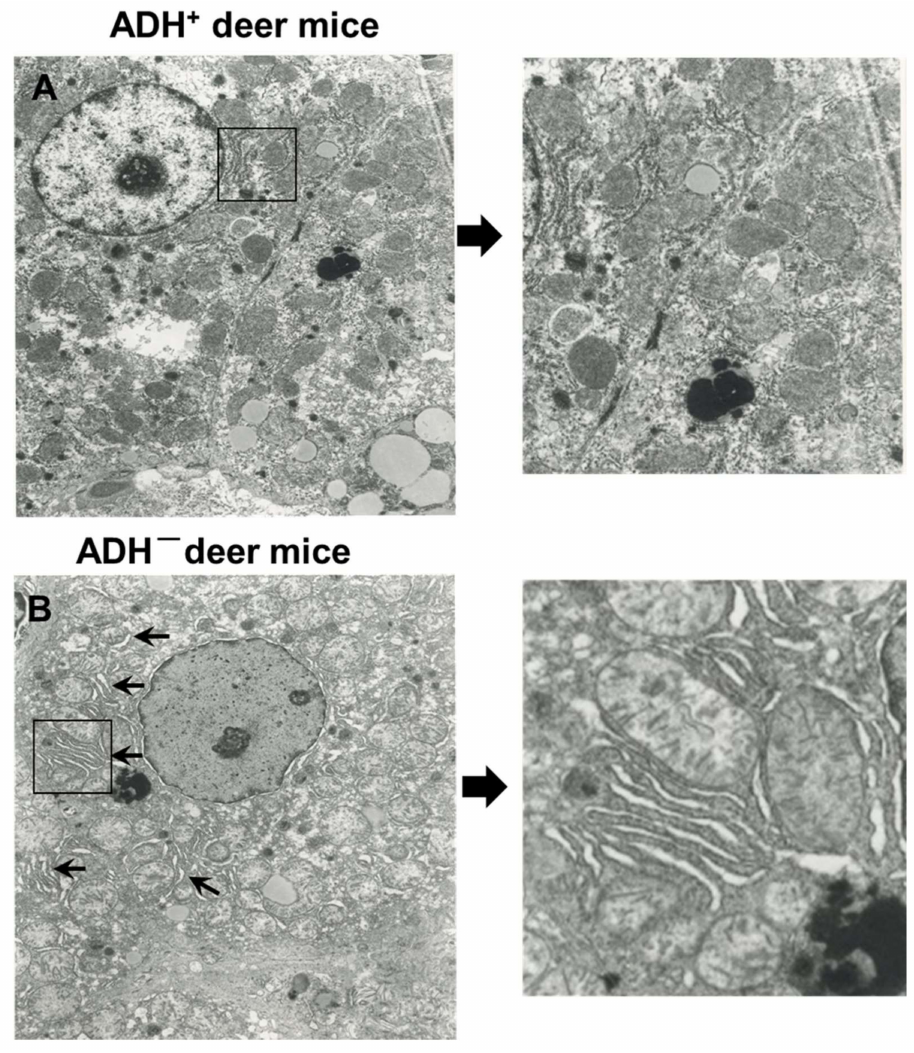
Figure 2. Electron micrographs of liver sections of ADH + deer mice ( A ) and ADH – deer mice ( B ) fed 3.5% EtOH for 2 months. Arrows and magnified image showing dilation and swelling of ER and ER cisternae only in the hepatocytes of ADH − deer mice fed 3.5% EtOH (original magnification × 14500). However, the ER appears normal in hepatocytes of ADH + deer mice fed 3.5% EtOH. 3.2. Blood Alcohol and Acetaldehyde Levels, and Levels of Hepatic Injury Marker and CYP2E1 Dose-dependent increases for blood alcohol concentration (BAC; Figure 3A) were observed for + − EtOH-fed ADH versus ADH deer mice. BAC was < 10 mg / dL or mg% in the deer mice fed 1% and 2% EtOH, but exponentially increased in both strains fed 3.5% EtOH. The average BAC was about + − two-fold greater in ADH deer mice (~148 mg%) compared to ADH deer mice (~78 mg%) fed 3.5% − EtOH. Blood acetaldehyde was also increased in ADH deer mice fed 3.5% EtOH, but the average concentrations were not significantly di ff erent than those of its pair-fed control (Figure 3B). In addition, plasma ALT activity, a marker for hepatic injury, was significantly elevated (about two-fold) only in − ADH deer mice fed 3.5% EtOH compared to its pair-fed control (Figure 3C). However, similar changes + in ADH deer mice fed EtOH compared to its pair-fed controls were not